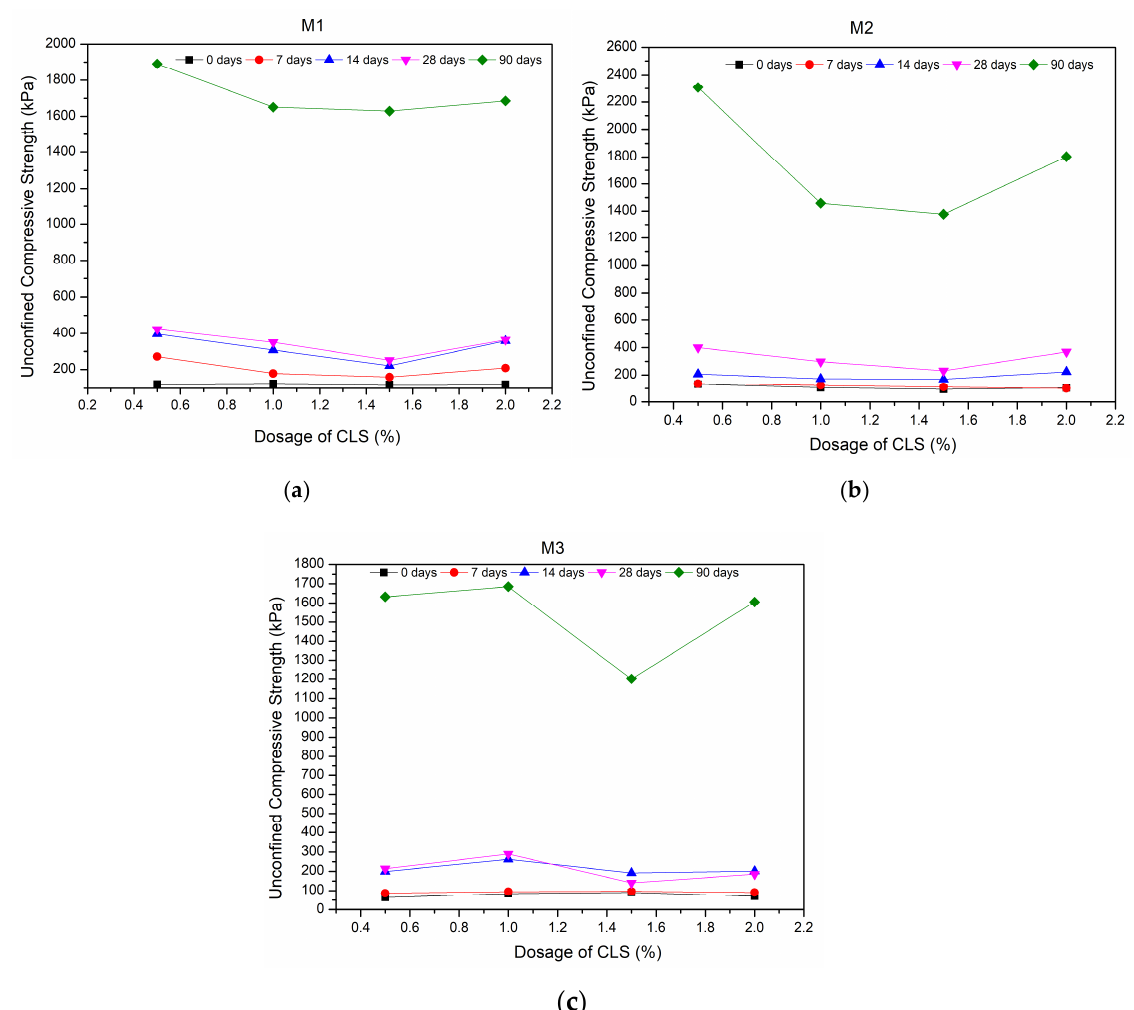
q with changes in dosage of CLS for ( a ) M1 ( b ) M2 ( c ) M3 mixes. Figure 3. Variation of Figure 3. Variation of q c with changes in dosage of CLS for ( a ) M1 ( b ) M2 ( c ) M3 mixes. c